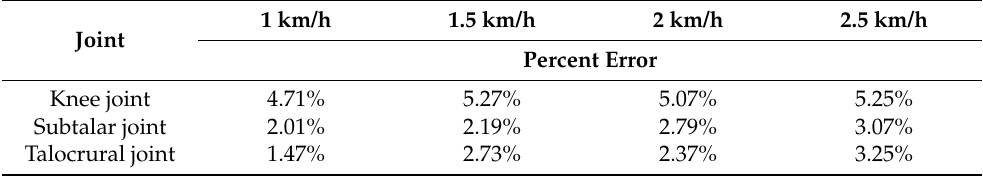
Table 6. Percent error (PE) of angle estimation simulation according to walking speed.